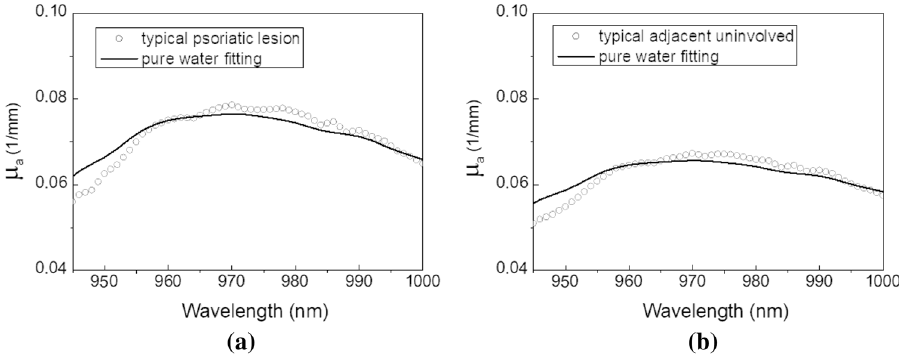
Figure 2. Typical skin absorption spectra of psoriatic lesion site and its adjacent uninvolved site of the representative psoriasis subject at the “second overtone” of water absorption. The absorption spectra of ( a ) the psoriatic lesion site and ( b ) its adjacent uninvolved site are shown in dotted lines. Best pure water absorption fitting to the skin absorption spectra are shown in solid lines.